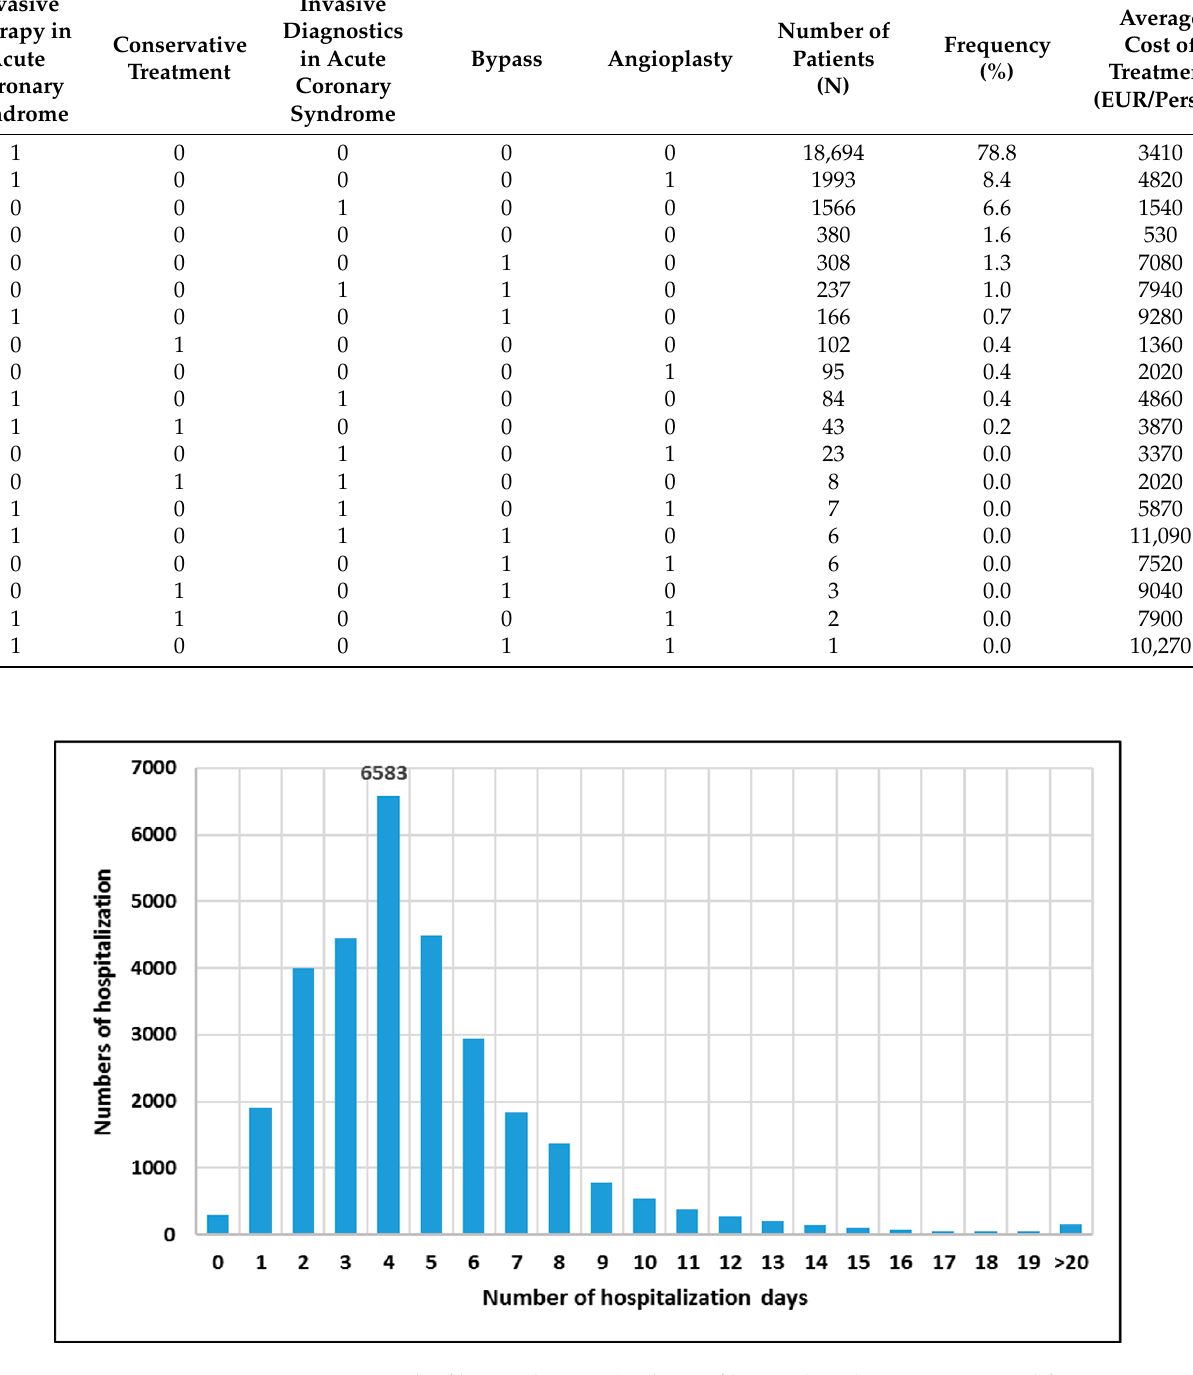
Table 3. Total costs of treatment (in EUR) of patients covered by CCMI.